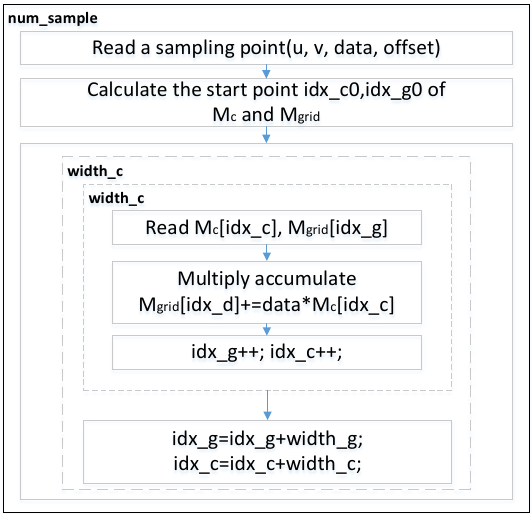
Figure 10. Data flow of the gridding algorithm.